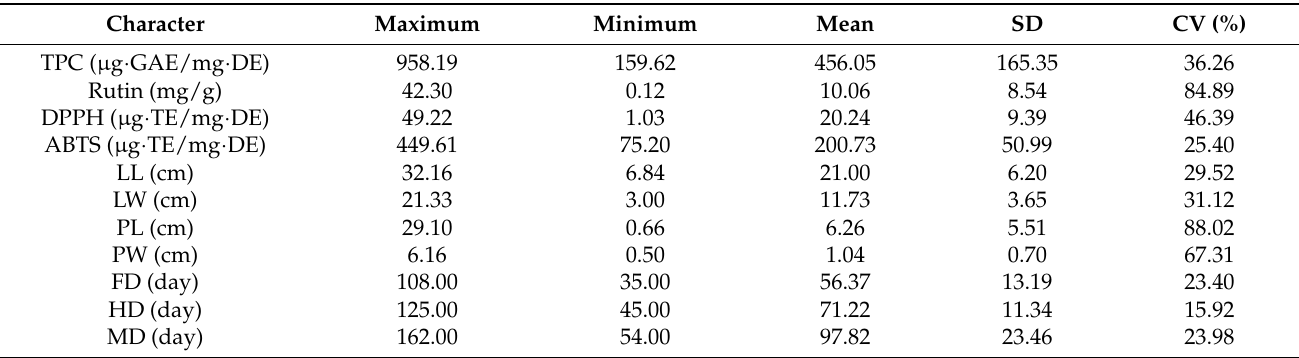
Table 1. Basic statistics of agricultural traits, the phytochemical content, and antioxidant activities of 289 Amaranthus